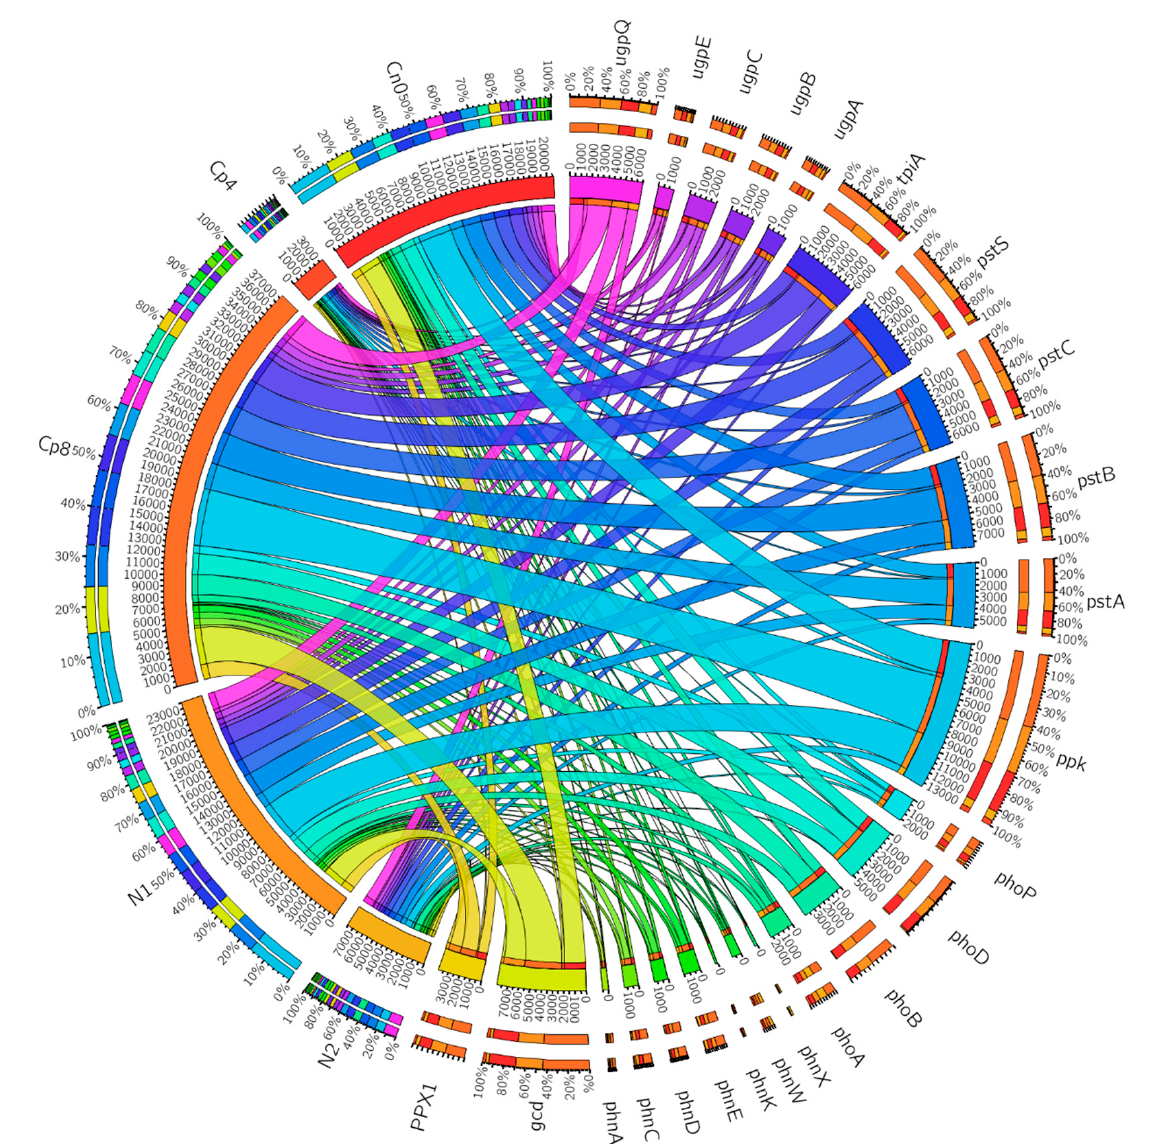
Figure 4. Phosphorous cycling genes relative abundance in the rhizosphere soil samples from maize plants under fertilization and unfertilized conditions as visualized by circus. Cp8 (8 tons/ha compost manure), Cp4 (4 tons/ha compost manure), N2 (120 kg/ha inorganic fertilizer), N1 (60 kg/ha inorganic fertilizer), and Cn0 (control). See Table S1. Table 2. Diversity indices of the phosphorus cycling genes within the rhizosphere of maize plants under treatments.